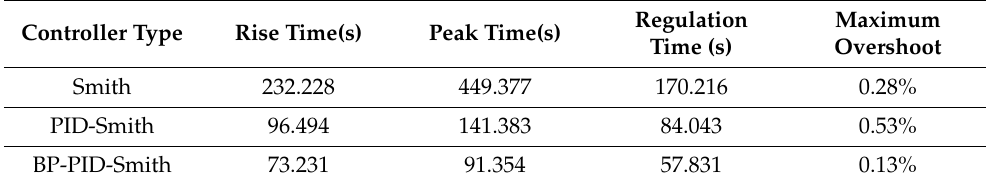
Table 2. Comparison of the dynamic performance of the three controllers for the model mismatch.